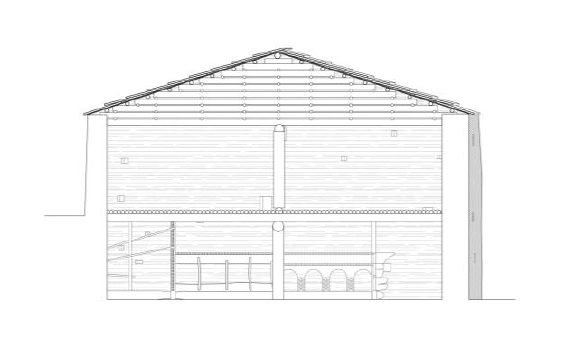
Figure 4. Section of Machubi 10, Chazhashi, Ushguli, CI-ESG,